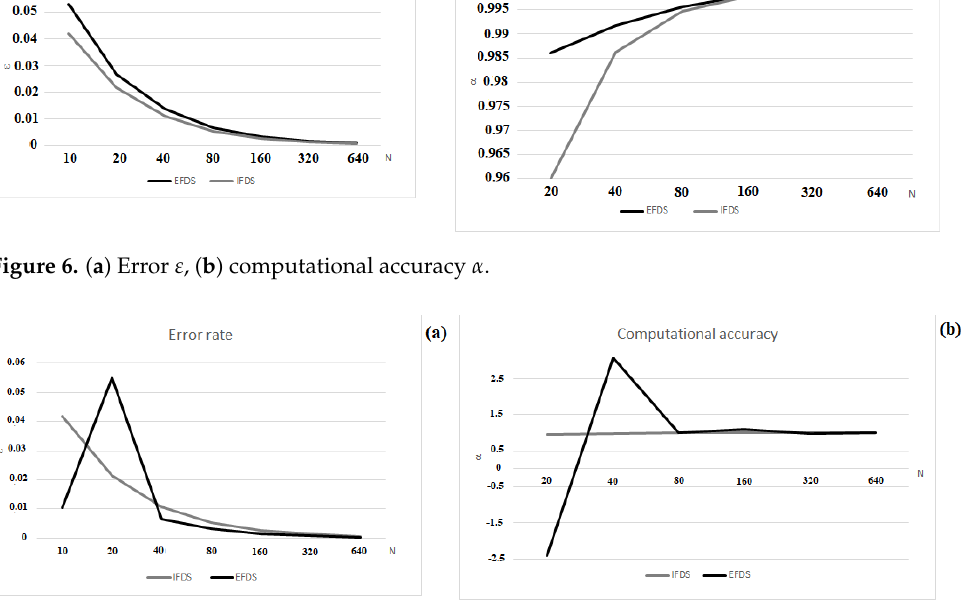
Figure 7. ( a ) Error ε , ( b ) computational accuracy α . The conditions of Theorems 1 and 2 are